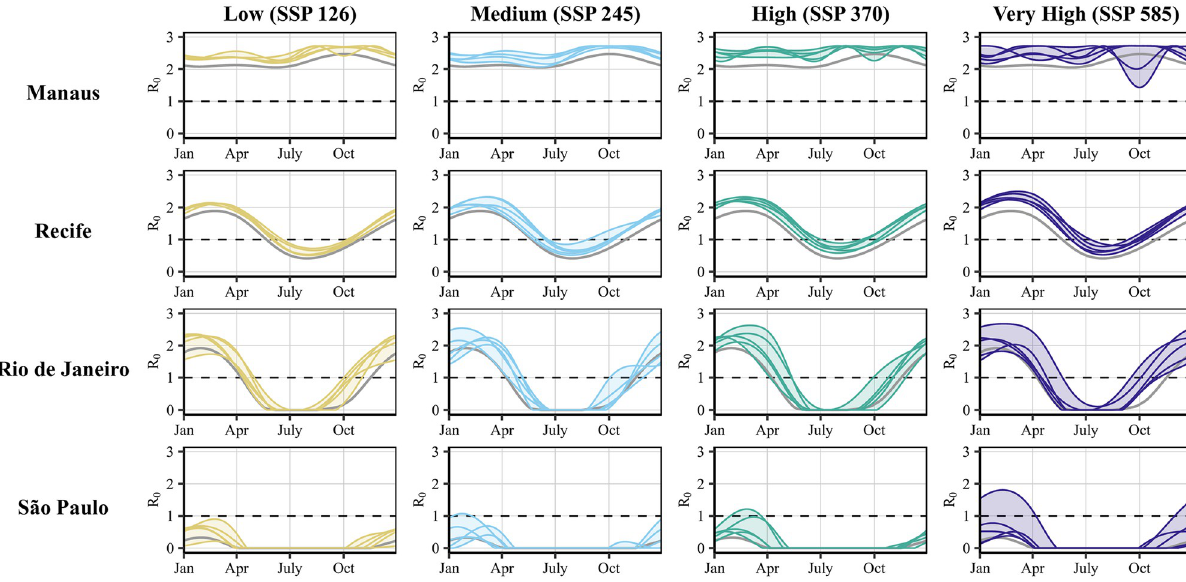
Fig 4. Year-to-year heterogeneity in projected Zika risk across climate change scenarios. Each panel shows projections of the seasonal temperature in years 2015–-2019 for a specific climate change scenario and each city, demonstrating year-to-year heterogeneity in projected risk. Grey lines corresponding to the historical baseline are plotted for comparison. Ribbons were added to highlight the vertical spread in the lines for each year.